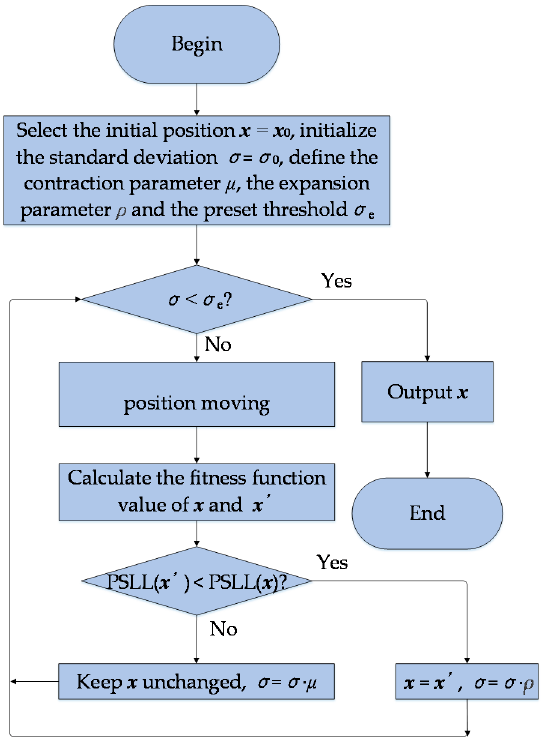
Figure 3. The flowchart of the local search strategy.